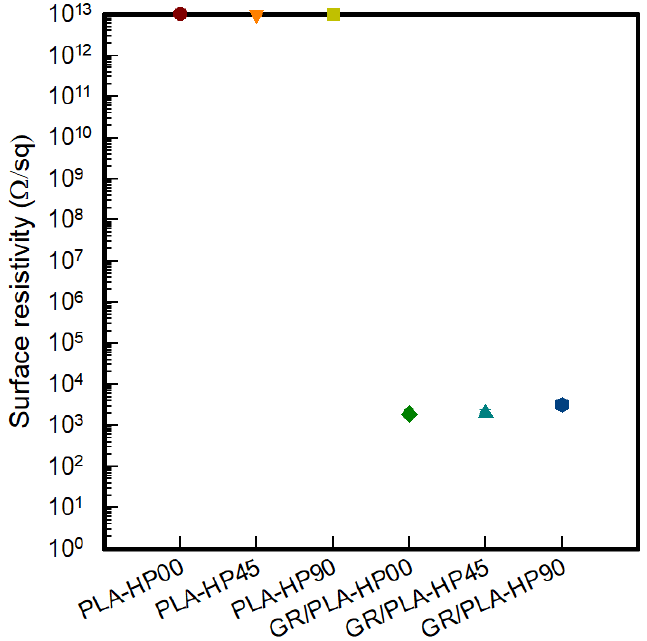
Figure4. SurfaceresistivityofCFDM3D-printedhorseshoepatternwithdi ff Figure 4. Surface resistivity of CFDM 3D-printed horseshoe pattern with different 3D printing directions.